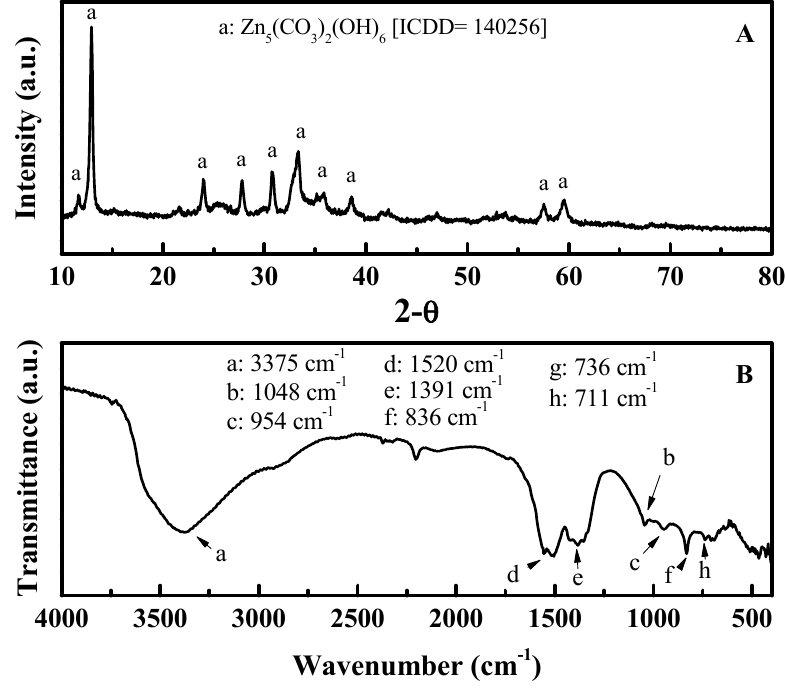
Figure 7. ( A ) X-ray diffraction (XRD) patterns of the Zn morphology shown in Figure 1(B); ( B ) Fourier Transform Infrared (FTIR) signature of the zinc basic carbonate particles shown in Figure